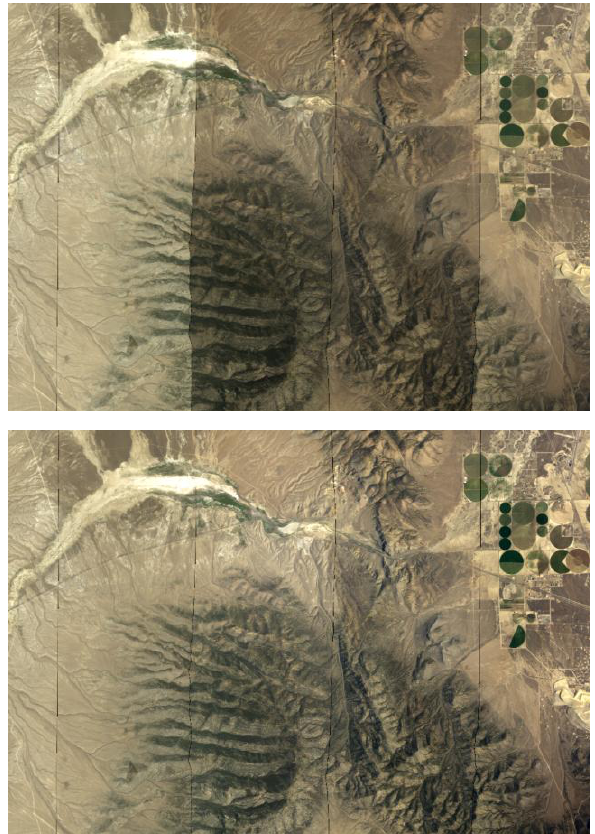
Figure 10. Sub-set of the ADS100 Nevada mosaic with the largest strip-to-strip differences before radiometric normali- zation. Top: imagery with atmospheric and BRDF corrections applied; bottom: final result after